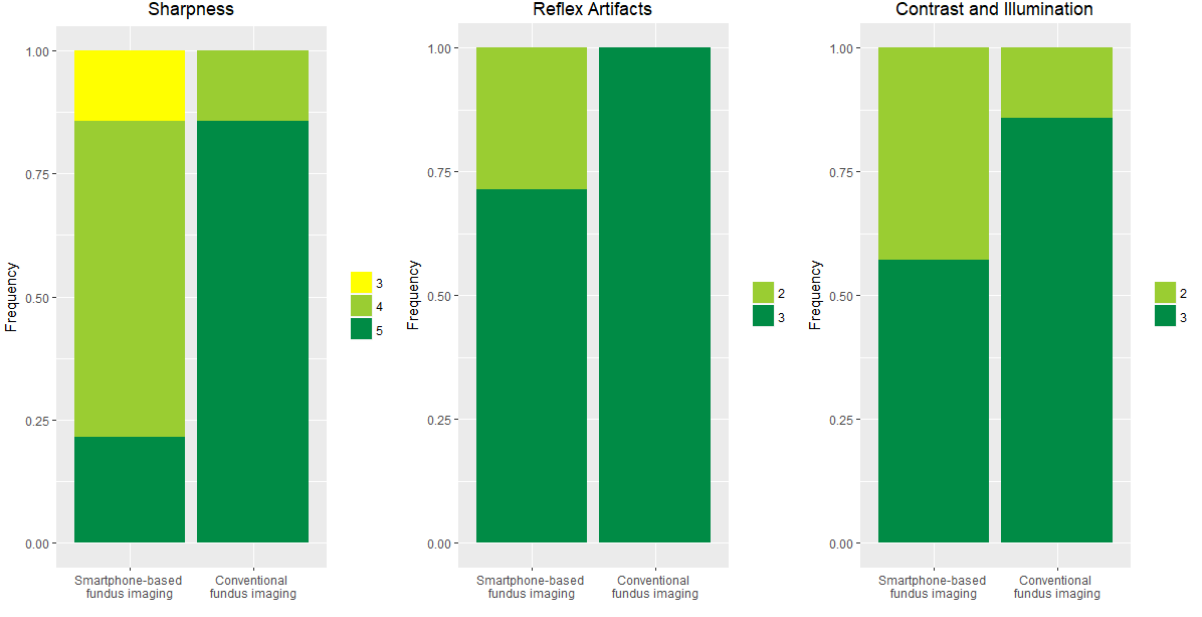
Figure 4. Comparison of image quality between smartphone and conventional fundus imaging. Image quality in terms of sharpness (left; semiquantitative scale from 1 to 5 as previously reported [22]), reflex artifacts (middle; scale from 0 to 3; 3=reflex artifacts in <10% of the field of view; 2=reflex artifacts in >10% of the field of view; 1=reflex artifacts in >30% of the field of view; 0=reflex artifacts in >50% of the field of view), and contrast and illumination (right; scale from 1 to 3; 3=all vessels contrast well against fundus pigmentation; 2=most vessels contrast against fundus pigmentation; 1=only few retinal vessels visible) is shown for smartphone-based fundus imaging and conventional fundus imaging.